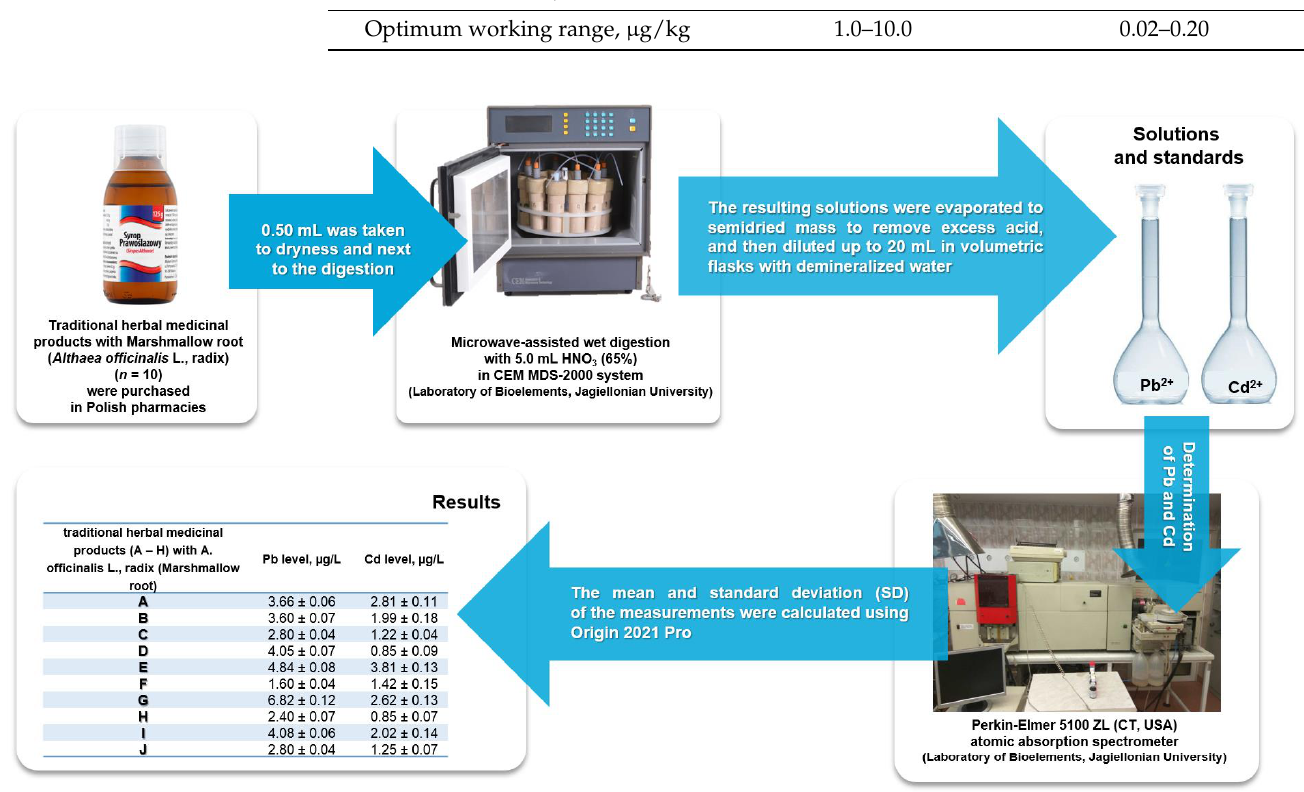
Table 3. The applied instrumental conditions for Pb and Cd determination by ET AAS. Operating Parameters